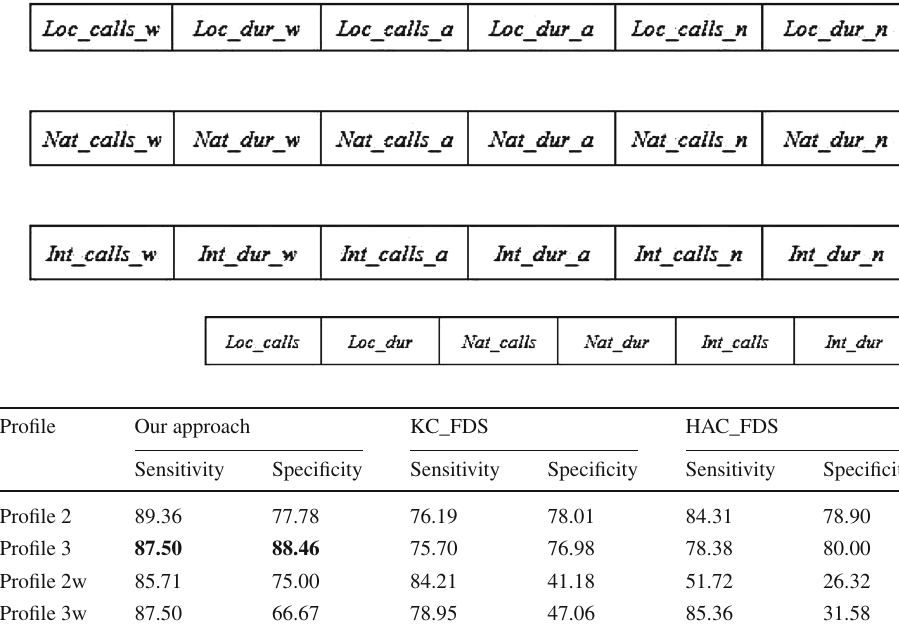
Fig. 6 Profile 3 of